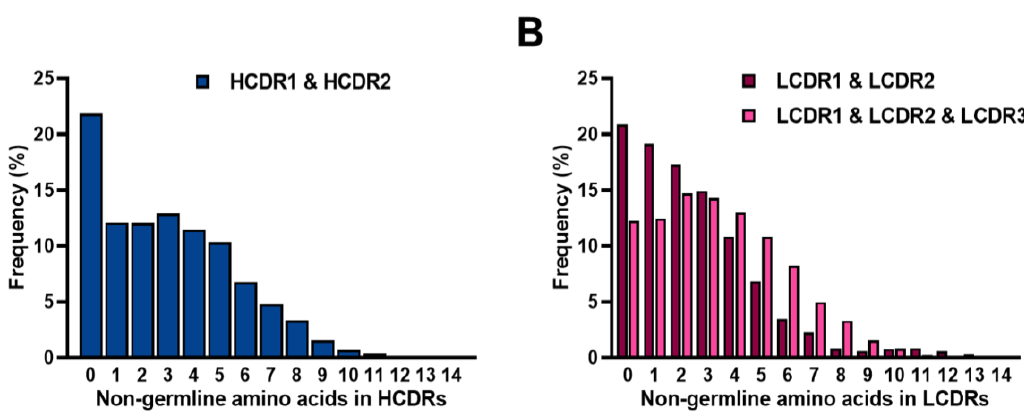
Figure 9. The frequency of non-germline amino acids in heavy chain complementarity-determining regions (HCDRs) or light chain complementarity-determining regions (LCDRs) in the constructed library. The numbers of non-germline amino acid residues found in HCDR1 and HCDR2 ( A ), LCDR1 and LCDR2, or LCDR1 and LCDR2 and LCDR3 ( B ) of the analyzed heavy chain variable domain (blue) and κ light chain variable domain (red) sequences were expressed as percentage bar graphs. The x axis shows the number of non-germline amino acids in CDRs.